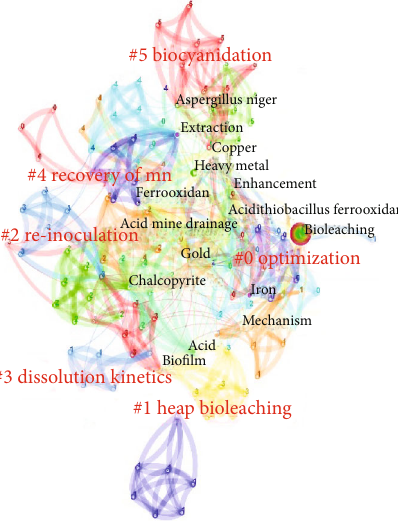
Figure 4: Analysis of label clusters with indexing